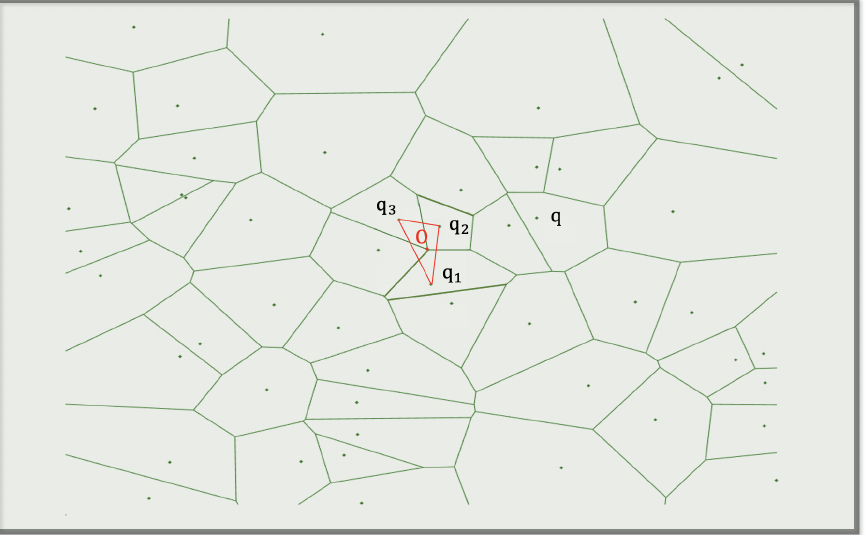
Figure 3. A plane Voronoi diagram schematic. q 1 , q 2 and q 3 are three arbitrary points in the given n points. Point O is the barycenter of (cid:52) q 1 q 2 q 3 . In a Voronoi diagram, there is a property where the vertex point is the barycenter of the triangle formed by the target points. Therefore, there will not be any other target points in (cid:52) q 1 q 2 q 3 . Point O is an arbitrary target point, so it must be outside of the triangle. In this case, (cid:52) q 1 q 2 q 3 can be considered the minimum